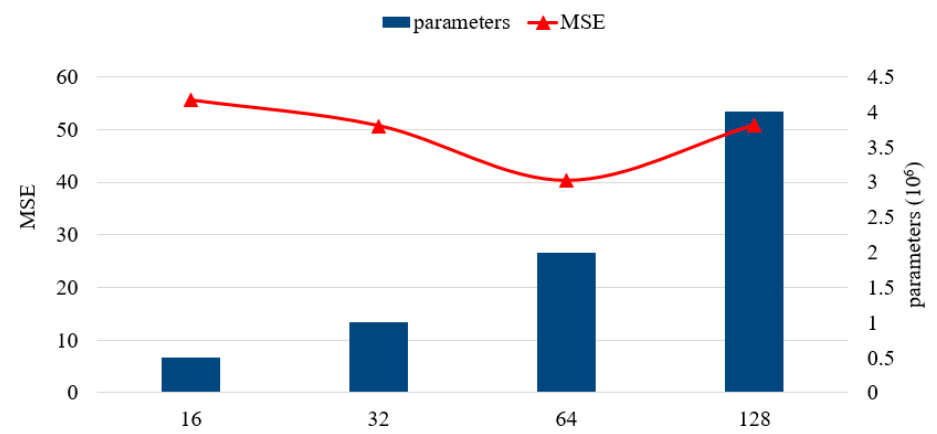
Figure 6. Number of filters.